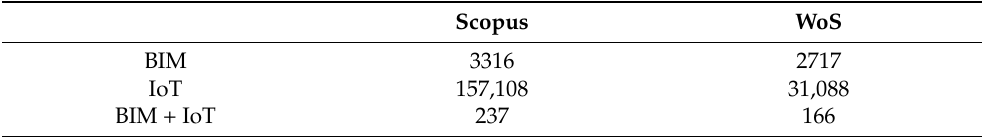
Table 3. Number of journal articles on BIM, IoT and their integration resulting from Scopus and WOS databases research (until February 2021).